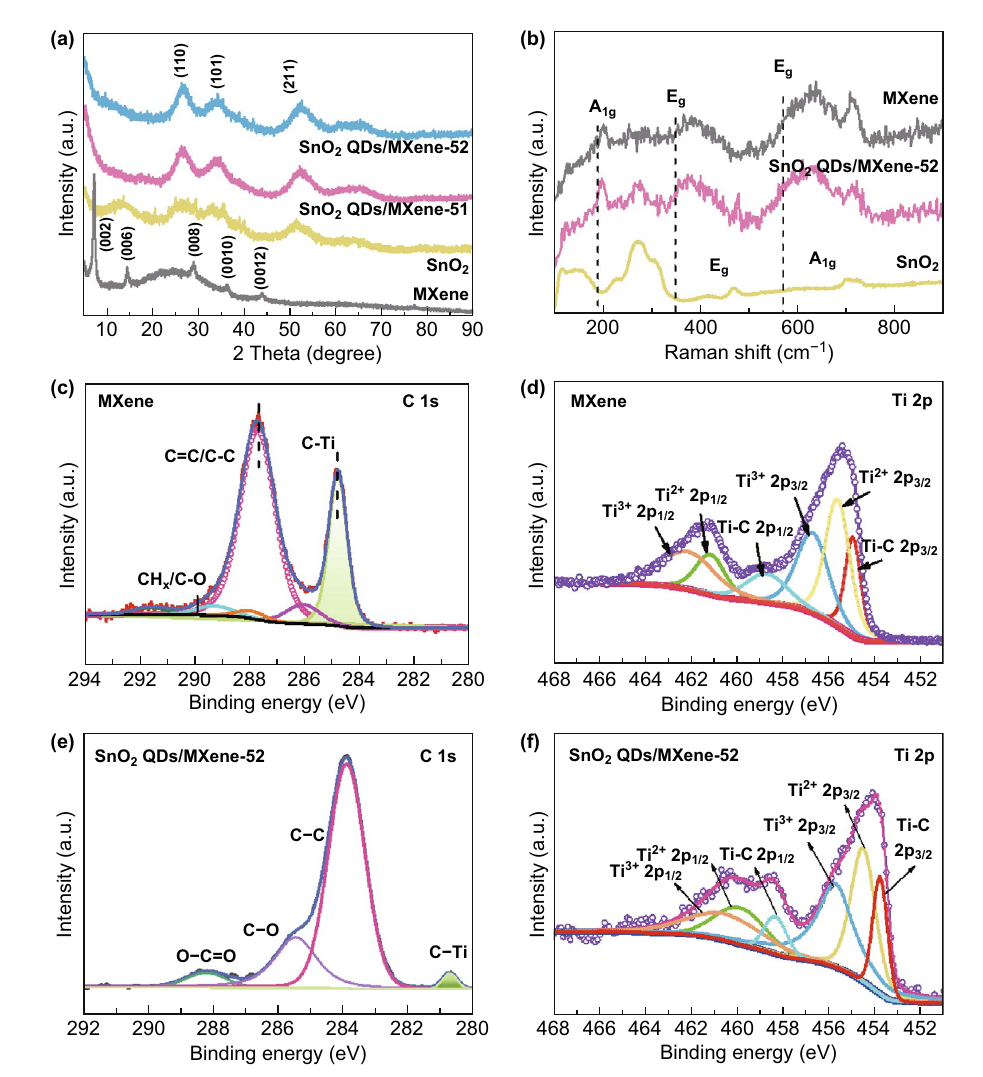
Fig. 3 a XRD patterns, b Raman spectra of MXene, SnO 2 , and SnO 2 QDs/MXene hybrid. XPS spectra of c MXene for high‑resolution C 1 s , d Ti 2p , e SnO 2 QDs/MXene‑52 for high‑resolution C 1 s , f Ti